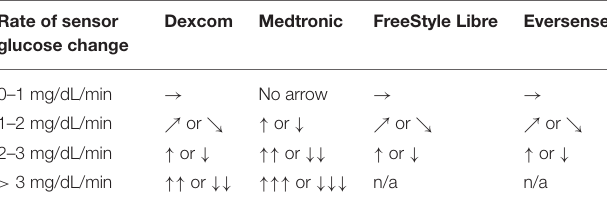
TABLE 4 | Rates of sensor glucose change as indicated by different CGM